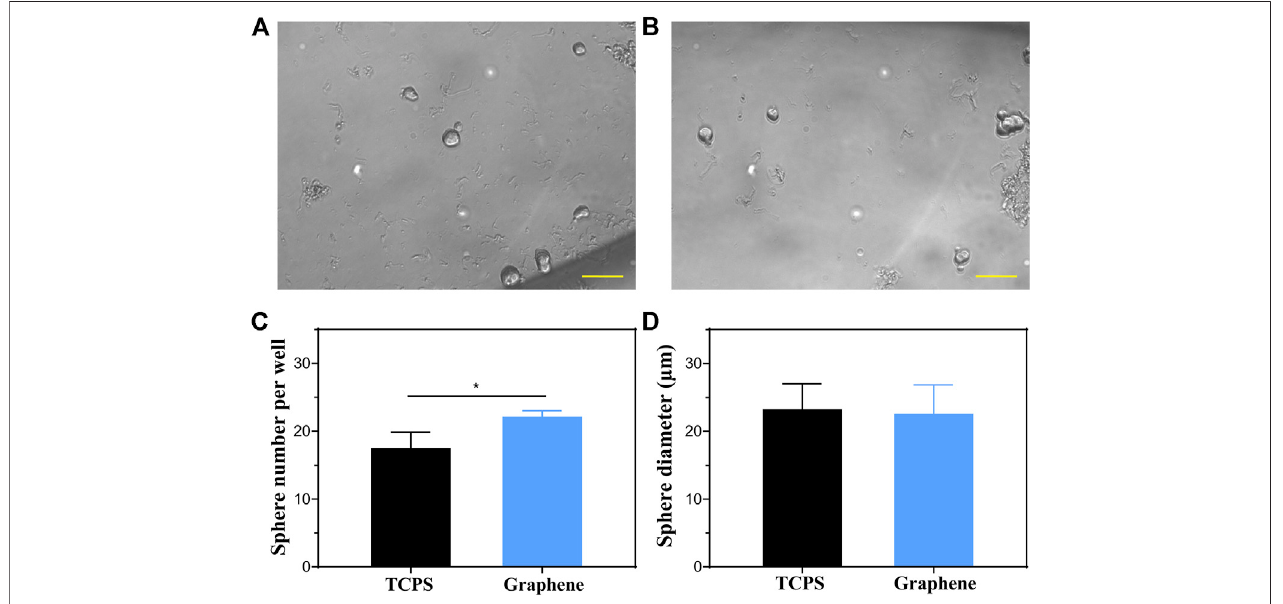
FIGURE3| Sphere-formingassayofLgr5+progenitors. (A,B) ThespheresformedbyLgr5+progenitorsculturedonTCPS (A) andgraphenesubstrates (B) . (C,D) The sphere number (C) and diameter (D) of Lgr5+ spheres cultured on different substrates. The scale bars are 50 μ m in (A,B) .